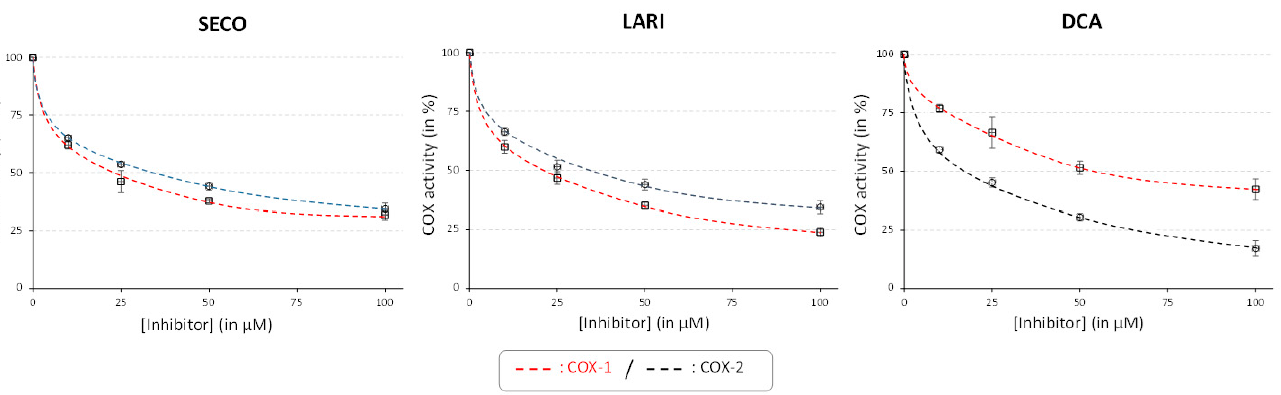
(COX-1/COX2 IC 50 Values) (in µM)